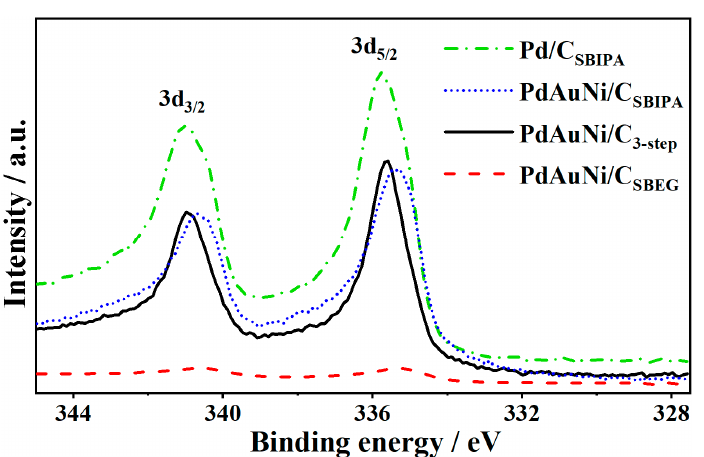
Figure 5. XPS spectra of Pd 3d in PdAuNi/C SBIPA , Pd/C SBIPA , PdAuNi/C SBEG , and PdAuNi/C 3-step , showing Pd 3d 3/2 and Pd 3d 5/2 peaks.